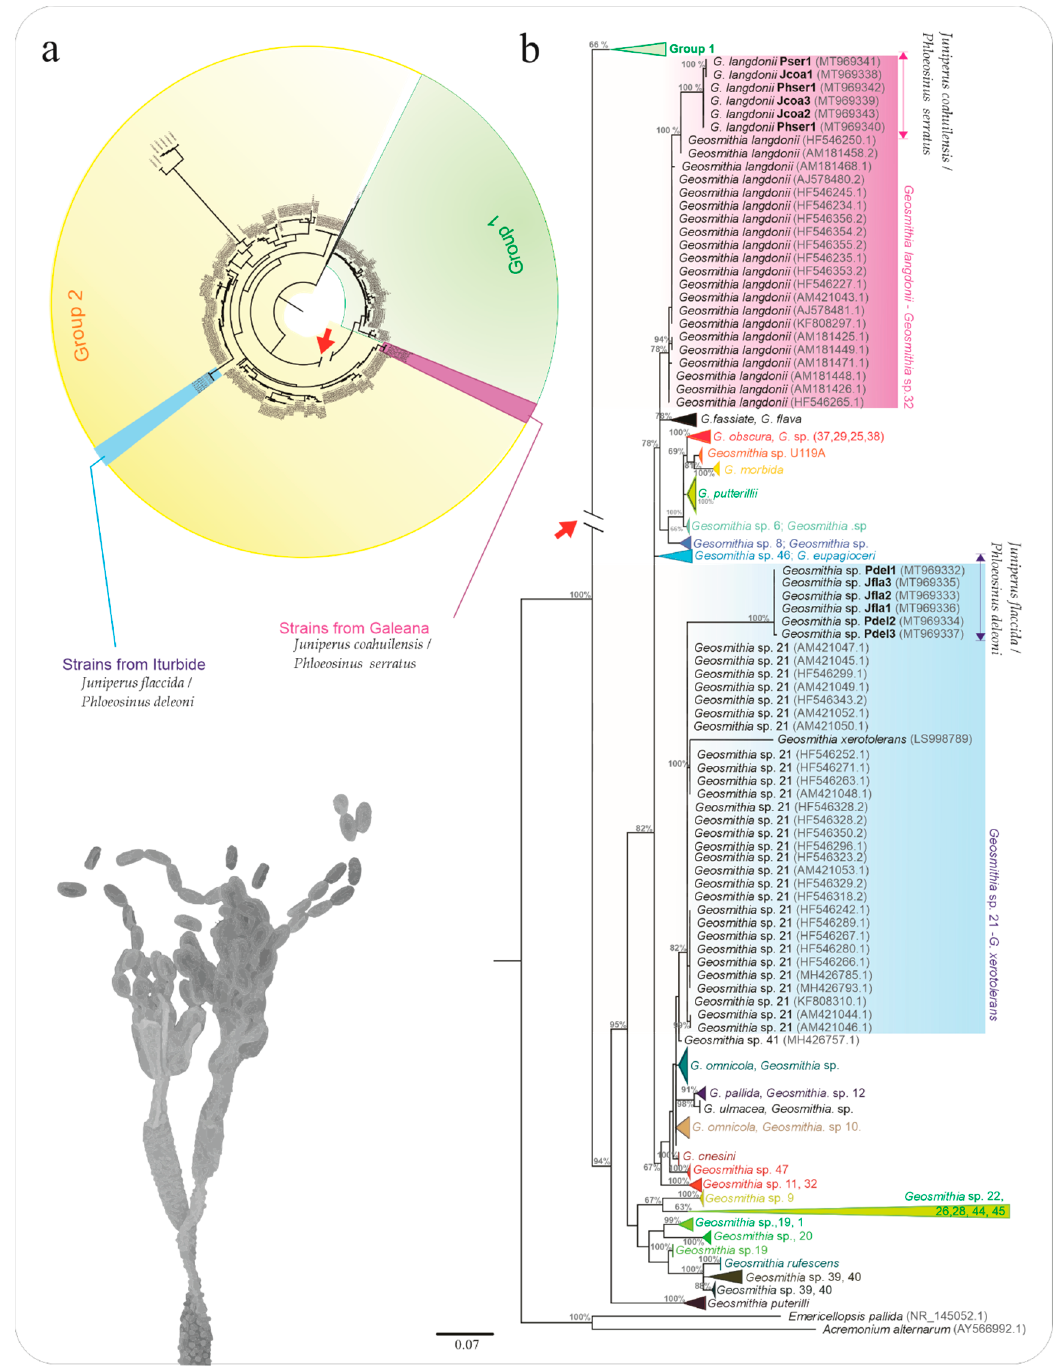
Figure 3. Phylogenetic relationship of the Geosmithia spp. isolated based on the internal transcribed spacer region (ITS). Pink and blue colors correspond to Geosmithia langdonii-Geosmithia sp. 32 and Geosmithia sp. 21- G. xerotolerans clades, respectively. ( a ) The phylogenetic tree resulting from the Maximum likelihood (ML) analysis of 378 ITS sequences; ( b ) “Group 2” of the phylogeny displayed in “a”. Red arrows indicate the cutting point. Target sequences of Geosmithia of this study are shown in bold. Emericellopsis pallida and Acremonium alternarum were selected as outgroups. Two subsequent phylogenetic trees were estimated, one of them focused on clarifying the position of sequences associated in the clade of G . langdonii-Geosmithia sp. 32, and the other one on those included in the Geosmithia sp. 21- G. xerotolerans clade. In both analyses, the target sequences were recovered within monophyletic groups, respectively, with bootstrap values of 100%. Phylogeny of G. langdonii-Geosmithia sp. 32 clade associated the sequences isolated from J. coahuilensis - P. serratus